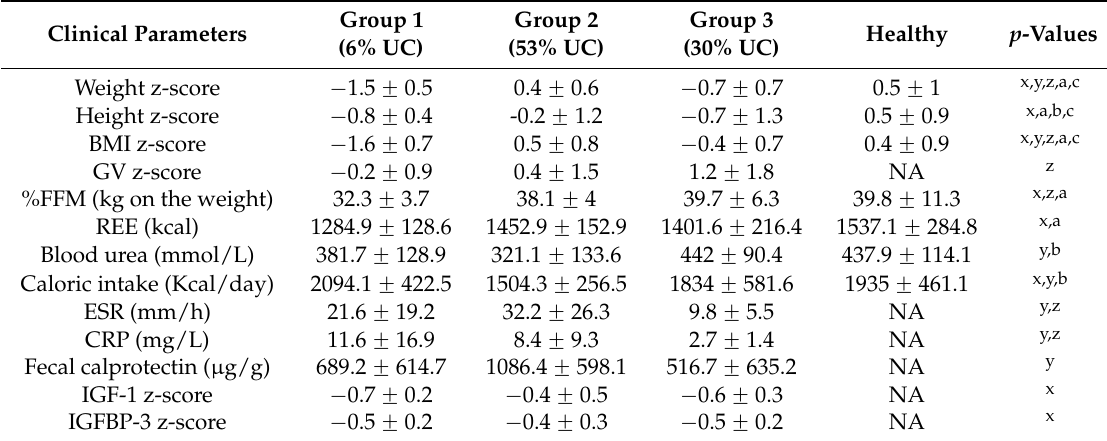
Table 3. Clinical